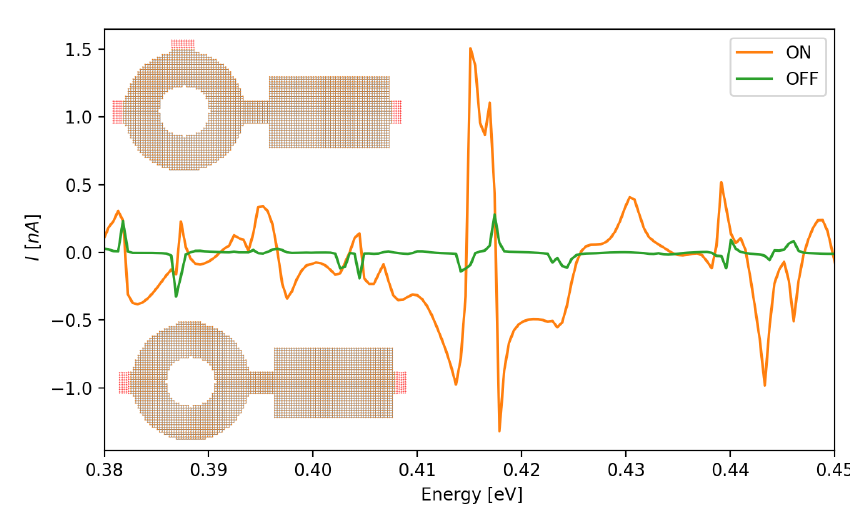
Figure 8: Demonstration of the on / off states of dynamical spin transistor. AC charge currents in Lead 1 as a function of the Fermi energy, generated by time-dependent and spatially inhomogeneous Rashba SOI, is plotted. Numerical results are based on the Floquet formalism. The charge current is calculated for both 2-Lead (inset below) and 3-Lead (inset above) systems. The dynamical Rashba SOI in the right ( t ) = k L = 1 and the spatially inhomogeneous half system is α sin ( Ω t ) with k R so so ( x ) = k ( L − y ) / L . The size of Rashba SOI in the left half system (the ring) is α R so each system part is L = 50 a and the driving frequency is Ω τ ≈